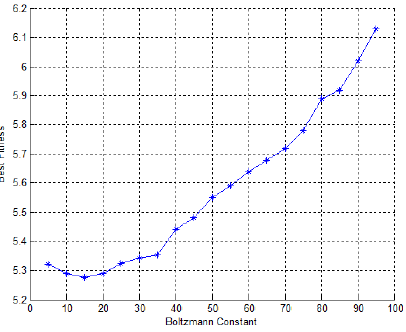
Figure 10. The best fitness value of the achieved routes over 100 independent rus under different Boltzmann